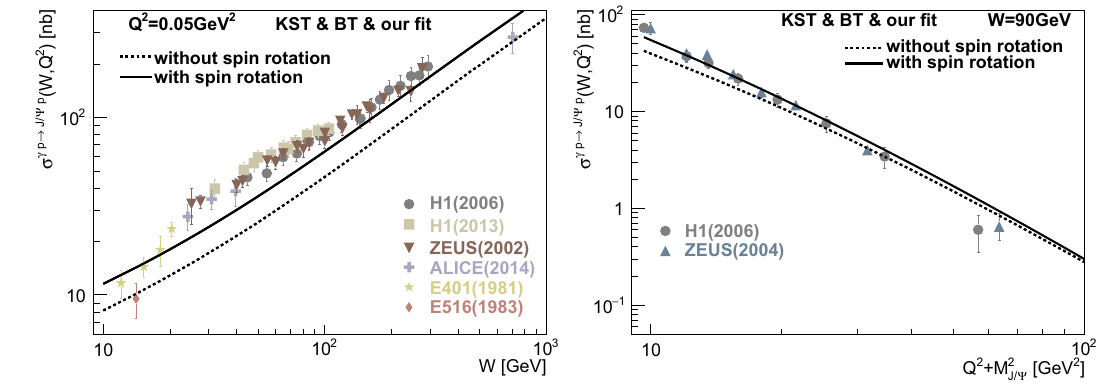
Fig. 19 The same as Fig. 7 but showing the effect of the Melosh spin rotation in the exclusive J /ψ electroproduction cross section shown as a function of c.m. energy W (left panel) and the scaling variable Q 2 + M 2